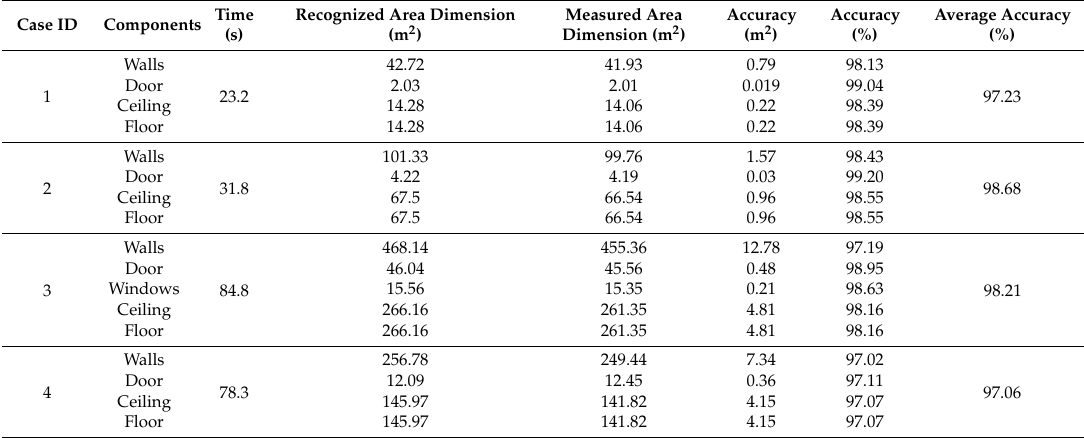
Table 2. Time consumption and the measurement accuracy of reconstructed